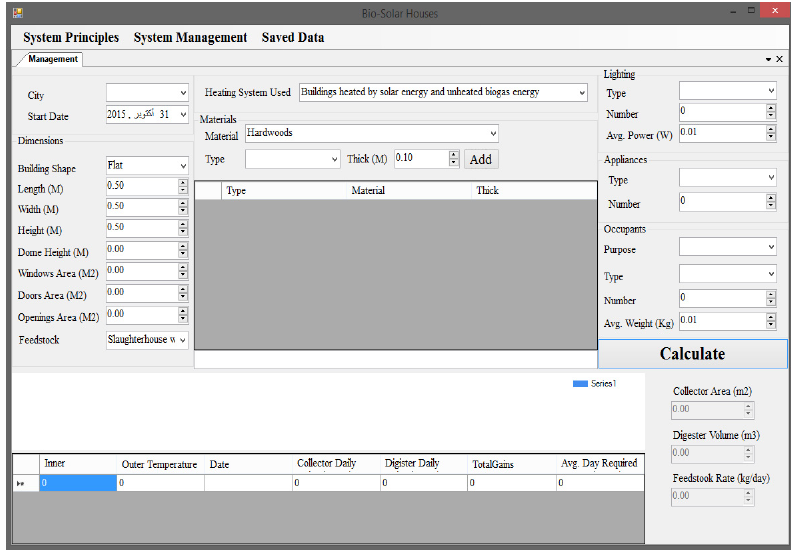
Figure 8. System management form in the model.